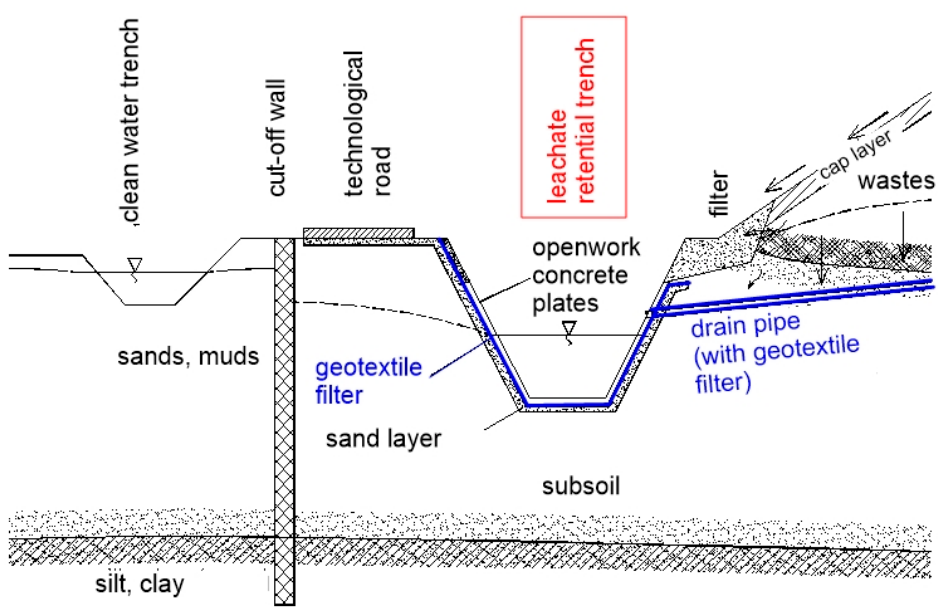
Figure 14. Radiowo landfill: drainage ditches construction.